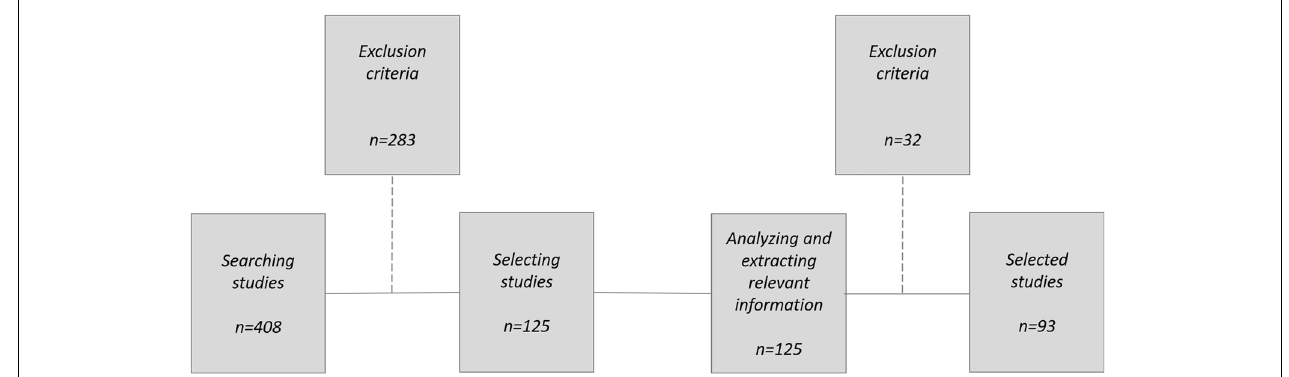
FIGURE 1 | Search procedure.